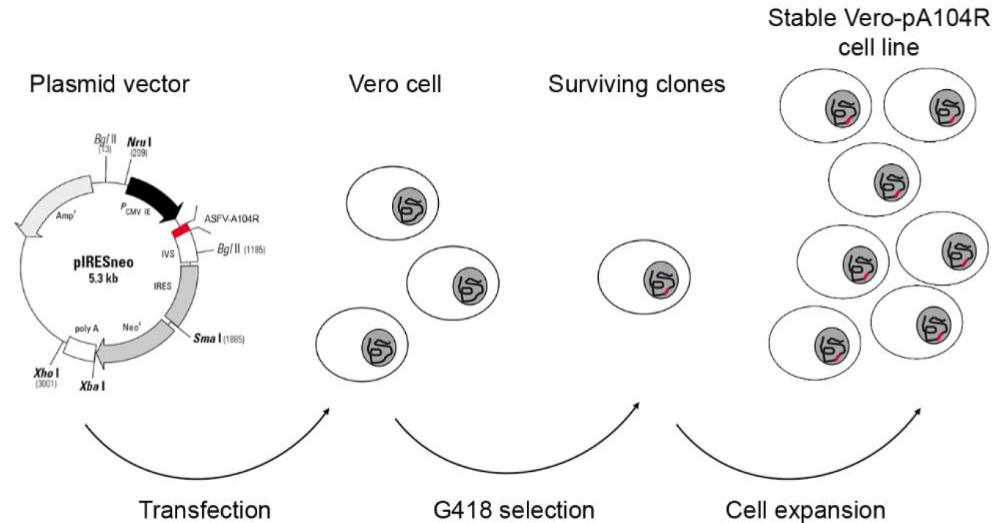
Figure 1. Schematic overview to generate helper cell lines expressing pA104R. Vero / COS-1 cells were transfected with the linearized pIRESneo_ASFV-A104R vector and then were subjected to antibiotic selective pressure. The surviving clones were expanded and the Vero-pA104R / COS-1-pA104R cell lines were established.